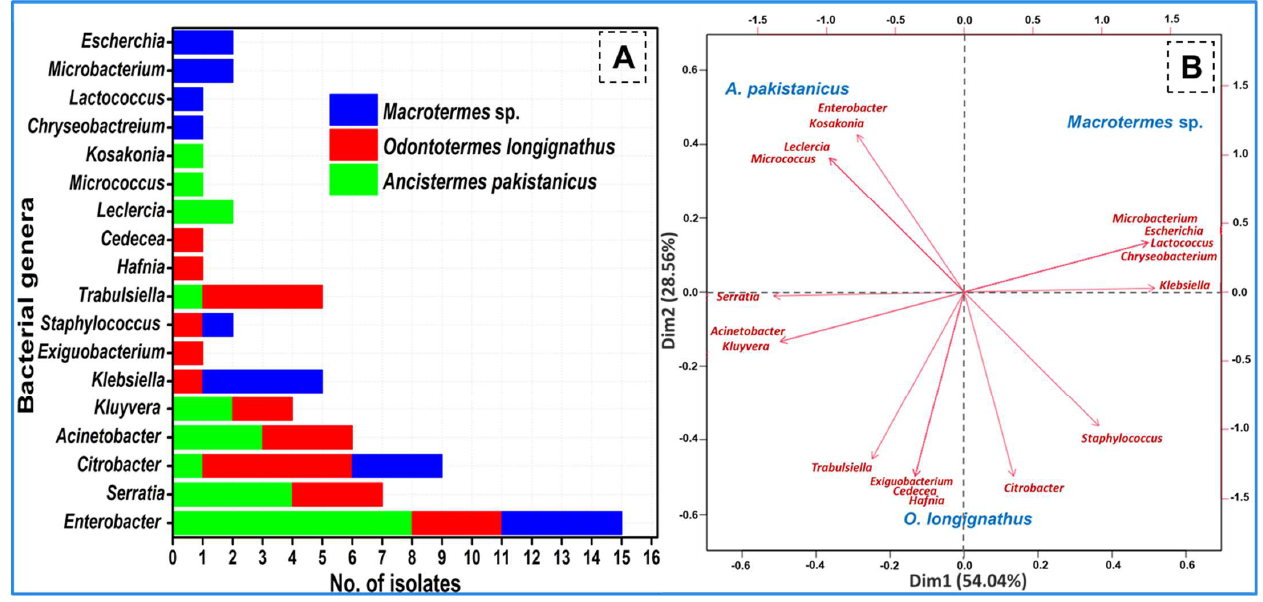
Figure 2. Genera-based distribution of Avicel- and xylan-hydrolyzing bacteria isolated from the gut systems of different species of fungus-growing termites. Genus-wise relative abundance of the o-served bacteria ( A ) and PCA ( B ) indicates the dominance of particular genus in specific termites.